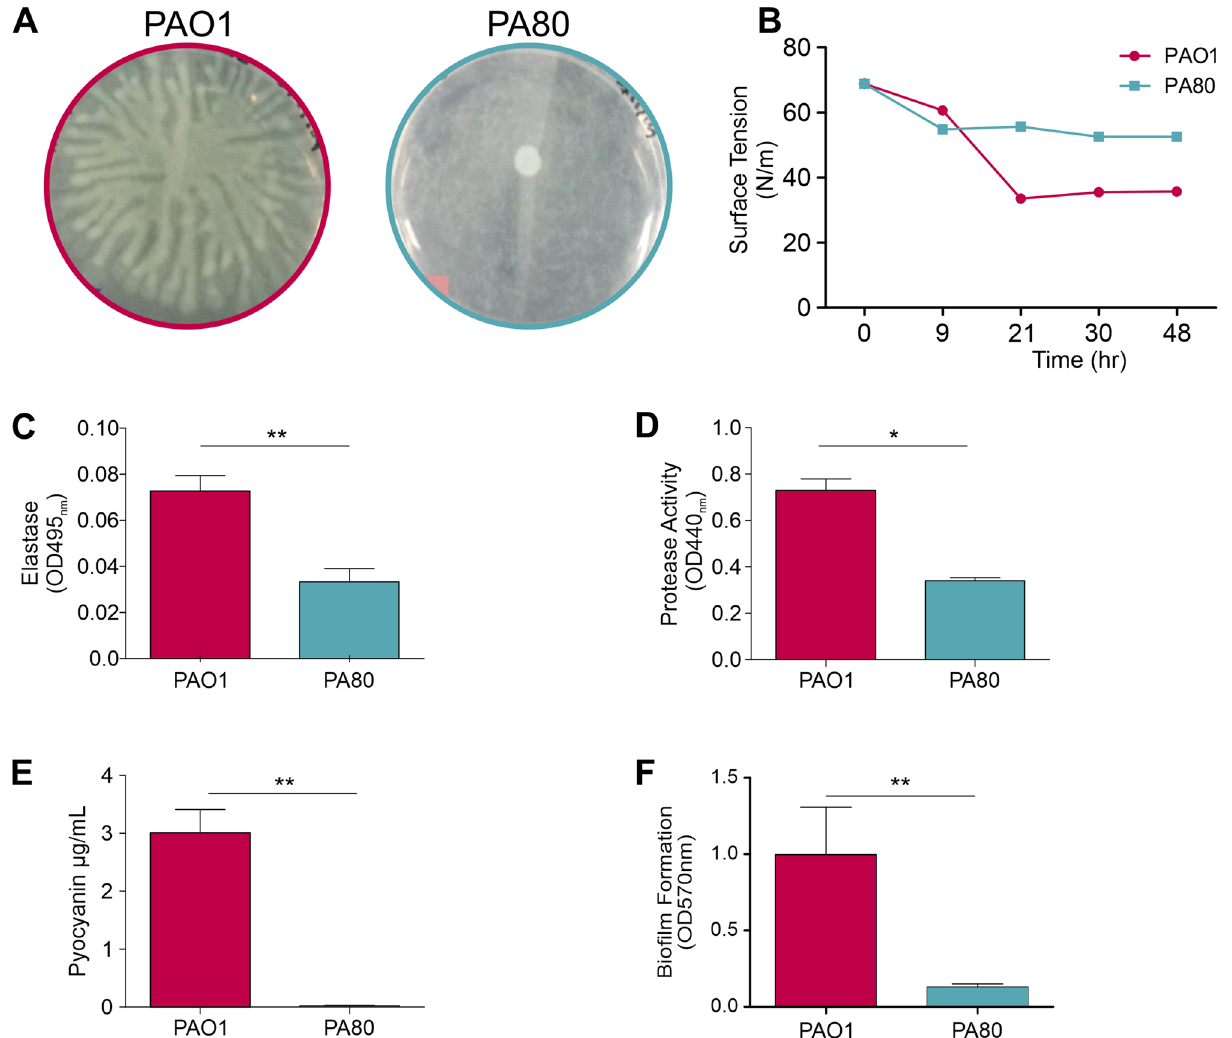
~ 38 (N/m). Production of ( C ) elastase ( D ) protease ( E ) pyocyanin and ( F ) biofilm in PAO1 and